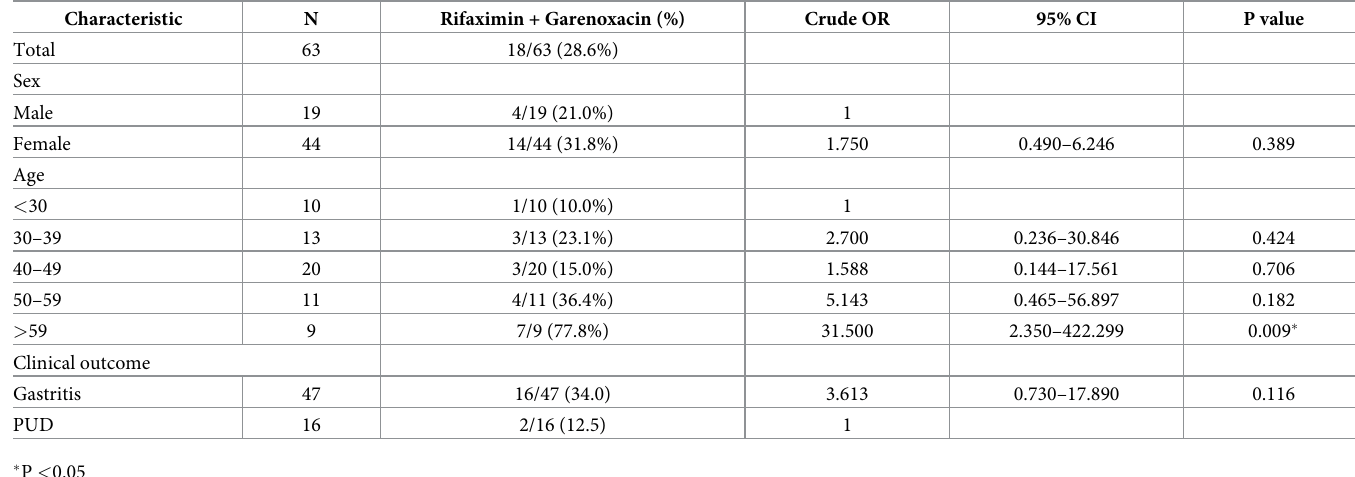
Table 2. Association between demographic and clinical outcome to rifaximin and garenoxacin double-antibiotic resistance in the Dominican Republic. Characteristic